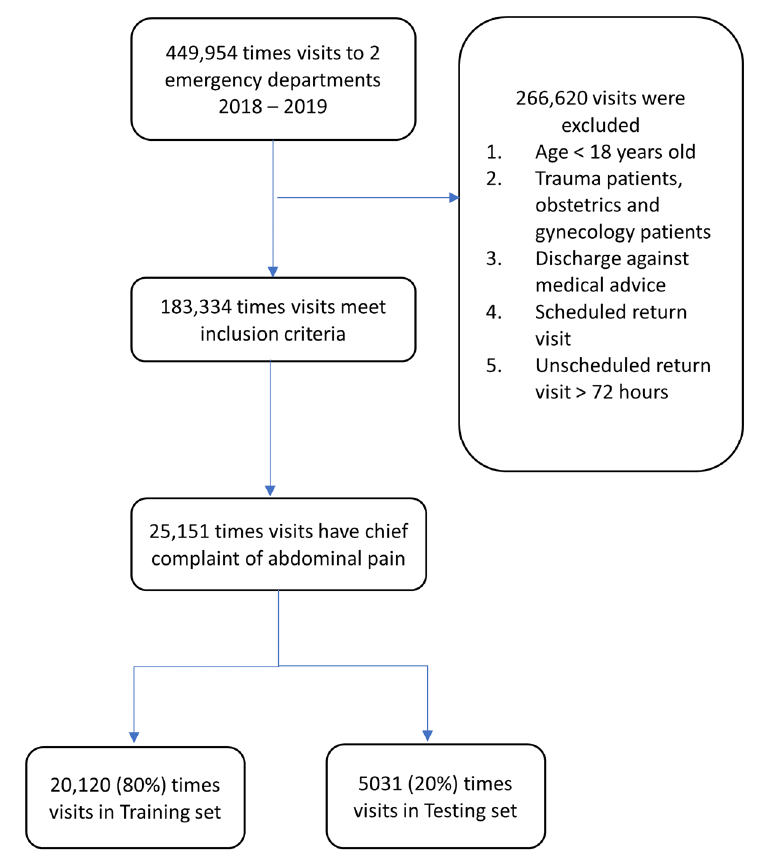
Figure 1. Study population and split of training and testing sets. Table 1. Summary statistics for demographic and clinical features of the